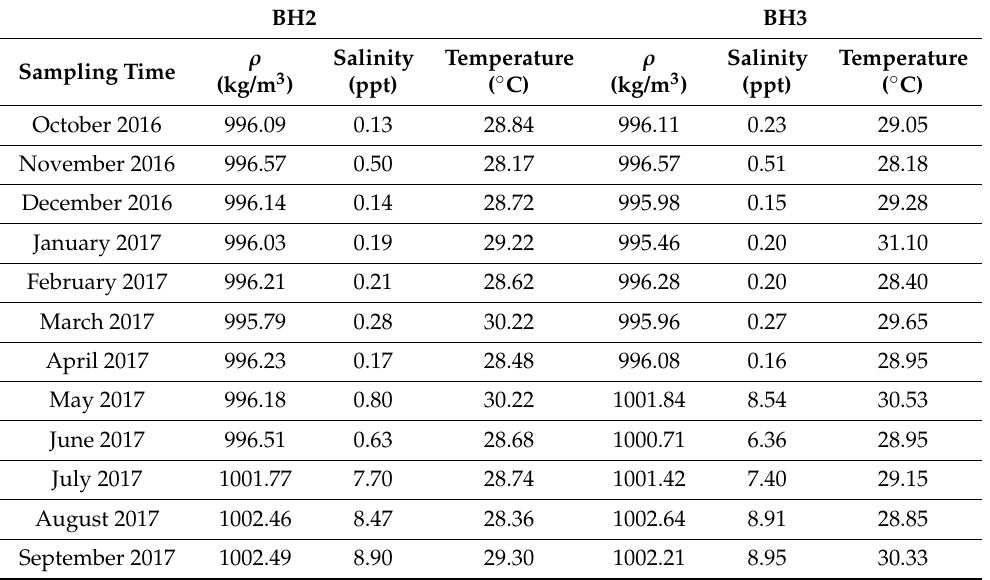
Table 1. Data measurement of water physics in the Bengawan Solo River estuary. BH2 BH3 Sampling